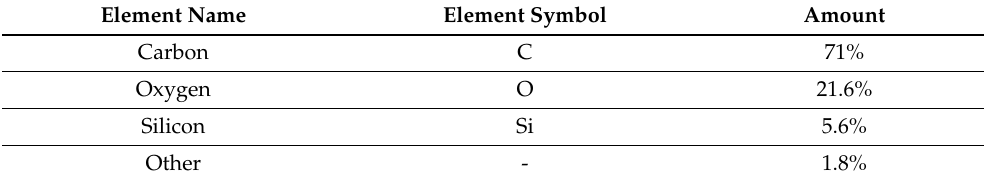
Table 2. Chemical composition of material